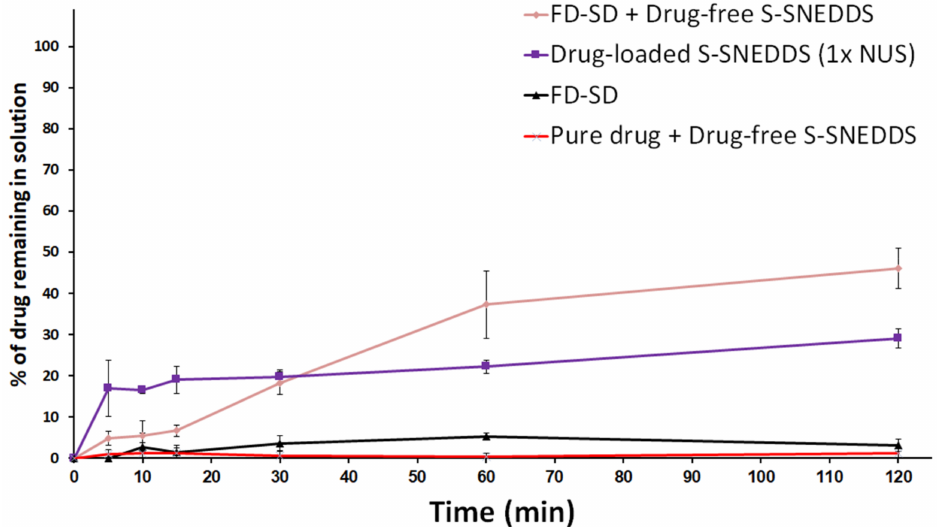
Figure 9. Effect of (SD + S-SNEDDS) combination on CN dissolution at pH 6.8. Data are expressed as mean ± SD, n =